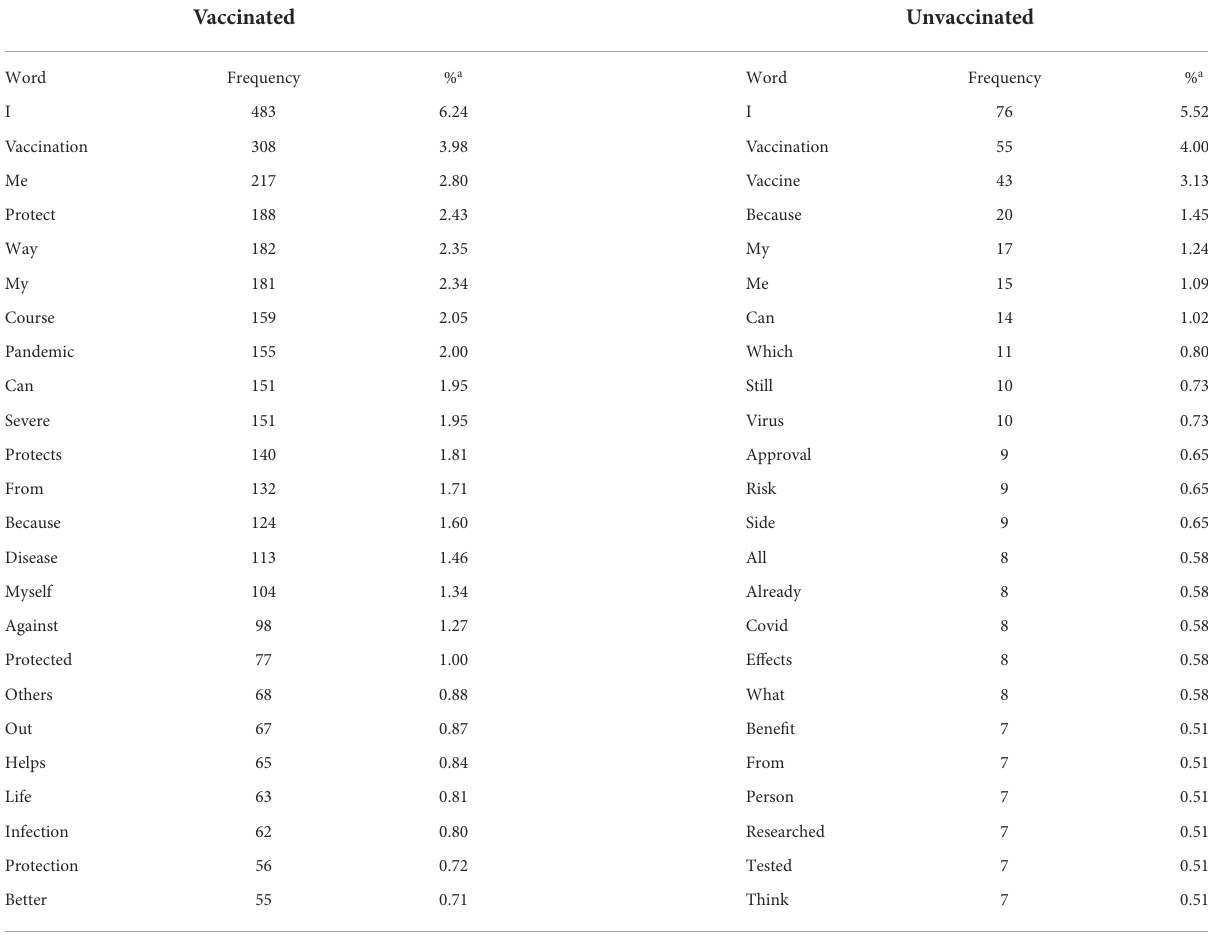
TABLE 6 Word frequencies of the 25 most frequent words for item 2 (“When I think about the COVID-19 vaccination, I believe”) in the Believing Questionnaire for the two groups. Vaccinated